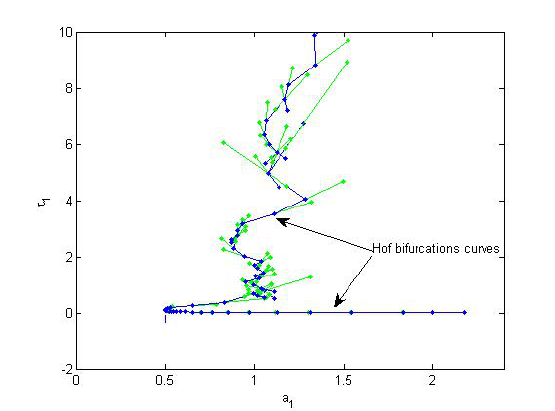
Fig. 8. Global Hopf bifurcations branches as we vary τ 1 and a 1 (same as varying R).